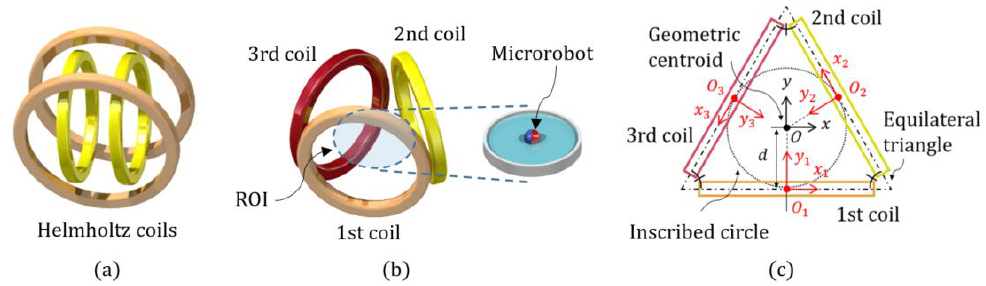
Figure 1. ( a ) Schematic view of the conventional two pairs of Helmholtz coils; ( b ) the TEC; ( c ) the geometrical properties shown in the xy -plane.